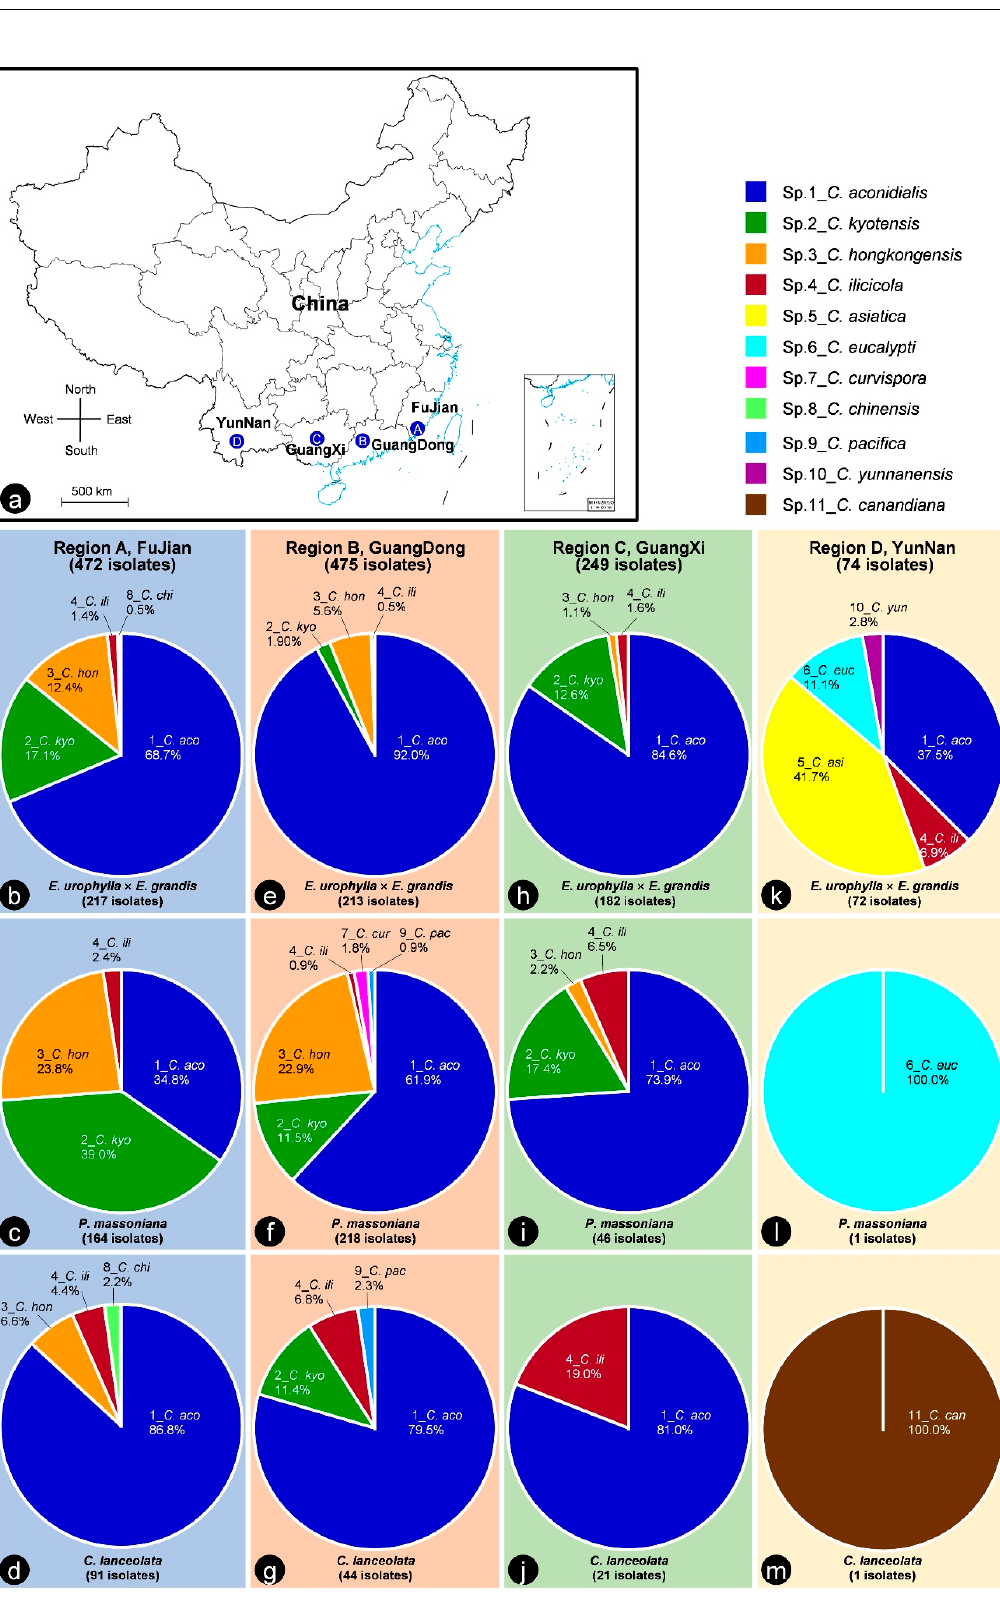
Figure 2. Calonectria species collected from soils in plantations of three tree species in four regions (provinces). ( a ). Map of China indicating the four regions in four provinces where soils were sampled; ( b – m ). Percentage of each Calonectria species in each plantation of Eucalyptus urophylla × E . grandis , Pinus massoniana , and Cunninghamia lanceolata in each of the four regions (FuJian, GuangDong, GuangXi, and YunNan Provinces). Different Calonectria species are indicated by numbers with different